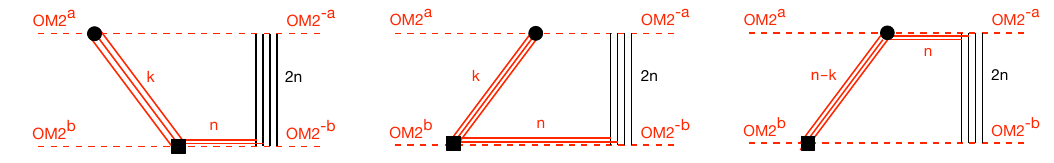
Figure 10 . The duality move in M theory for N = 2 n